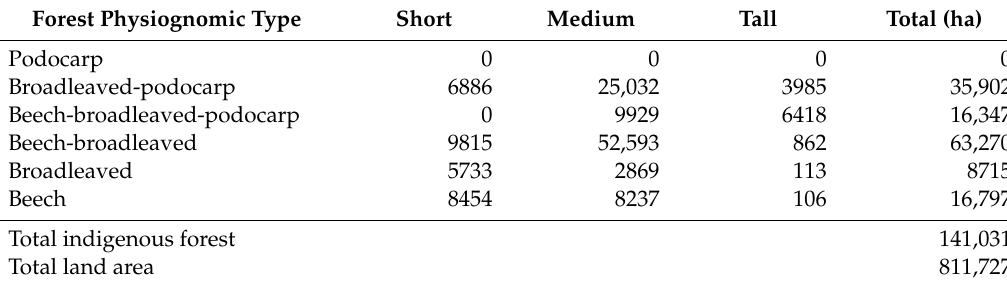
Table 4. Areas (ha) of physiognomic types of indigenous forest in the Wellington region by height class. Height classes are defined by the 97th percentile of CHM: short ( < 20 m); medium (20–30 m); and tall ( > 30 m).